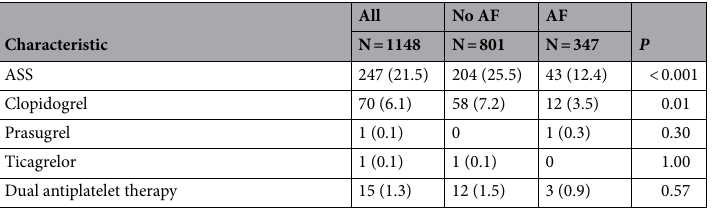
Table 1. Patients’ baseline characteristics. AF, atrial fibrillation; ASS, acetylsalicylic acid; BMI, body mass index; IQR, interquartile range; LMWH, low-molecular-weight heparin; n, number of patients; NOAC, non- vitamin K antagonist oral anticoagulant; P , p-value; SD, standard deviation; TIA, transient ischemic attack; VKA, vitamin K antagonists. a Excluding nonmelanoma skin cancer. Patients with multiple malignancies were counted once. b Prescribed within 5 days after January 1, 2014 or after admission between January 2014 and October 2017.